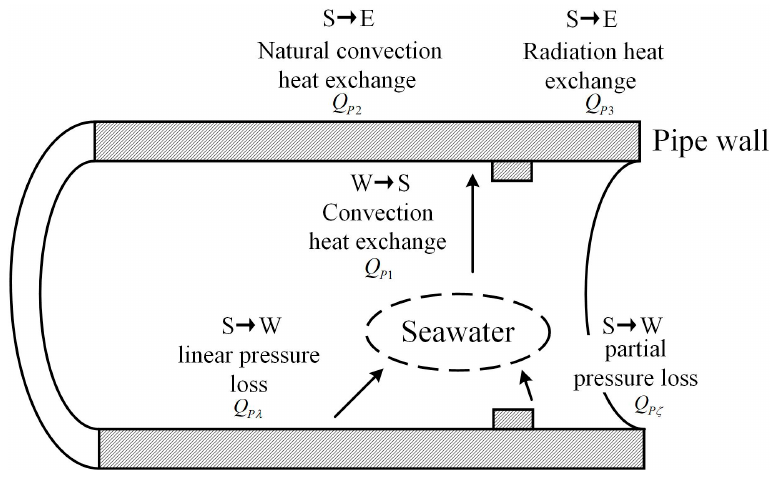
Figure 5. Schematic diagram of the heat exchange process of hydraulic pipe.